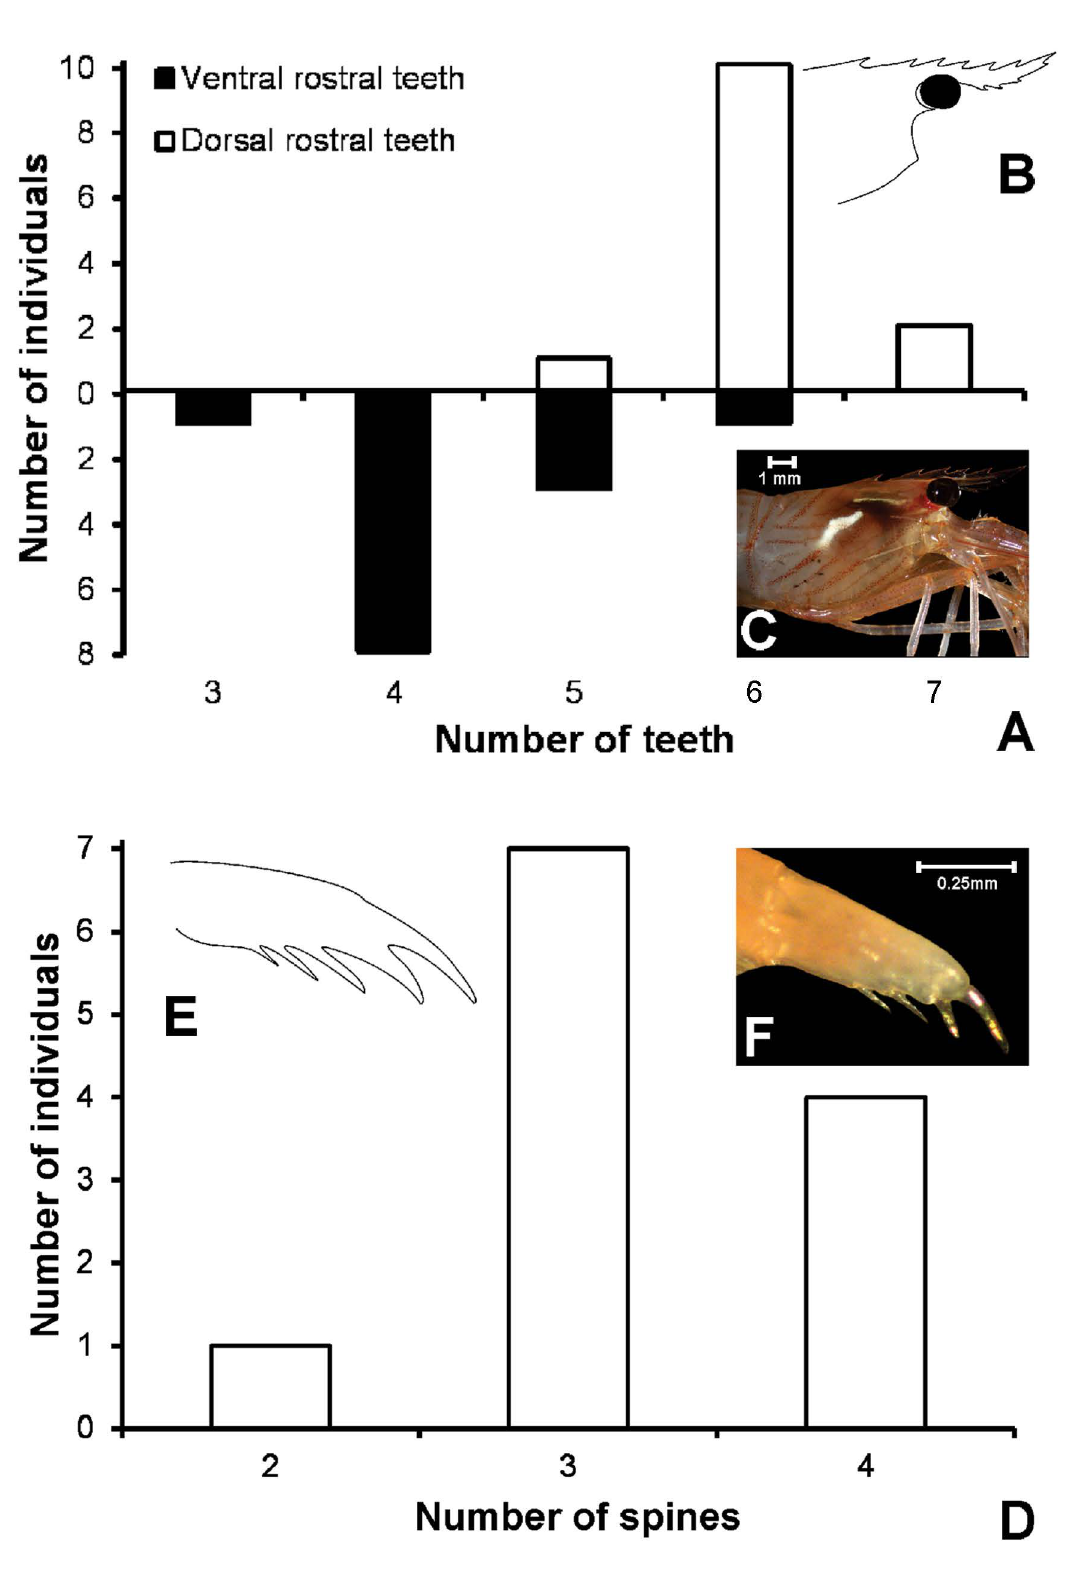
Figure 2. Lysmata ankeri. (A) Variation in the number of rostral teeth on the dorsal and ventral margins; (B) predominant rostral dentition; (C) dorsal rostral dentition with 5 teeth (Photograph: DFR Alves); (D) variation in the number of spines on the flexor margin of the dactylus of the pereiopod; (E) dactylus with the predominant number of spines; (F) dactylus with 2 spines (Photograph: DFR